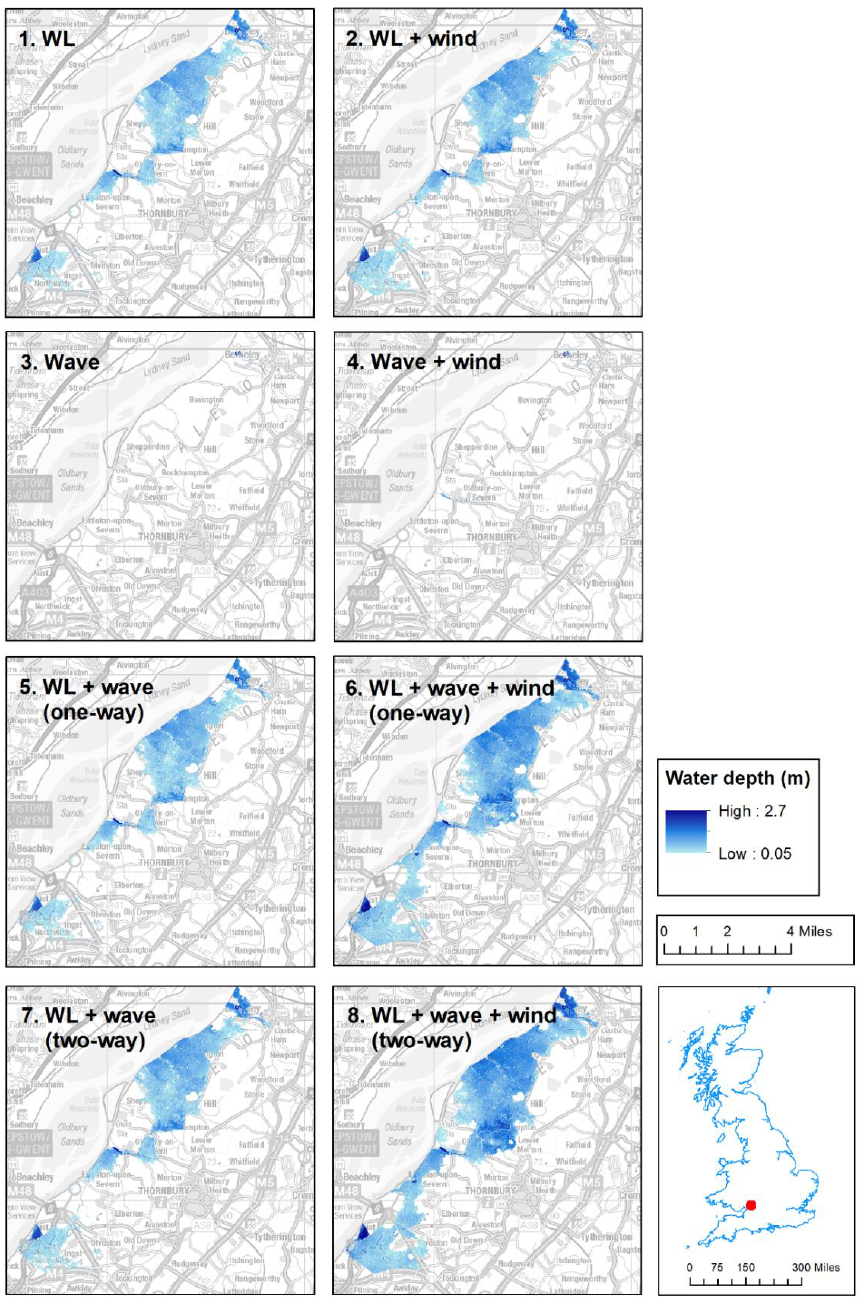
Figure 5. Depth and extent of flooding at Oldbury-on-Severn for WR approach to forcing the model boundary where maps 1–8 represent coastal hazard uncertainty (see Table 1) for January 14.